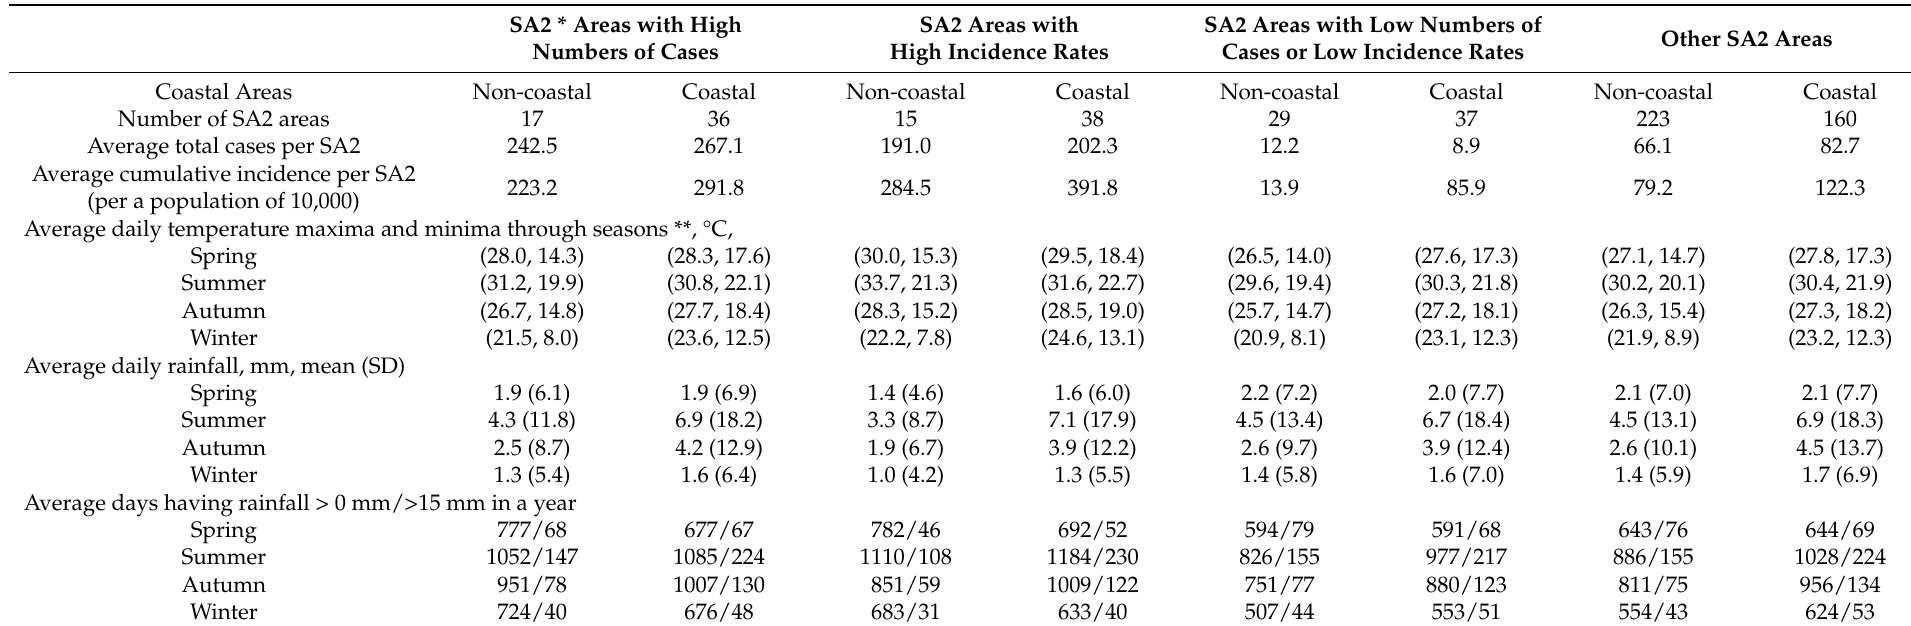
Table 1. The seasonal temperature and rainfall in SA2 areas with high numbers of cases or high incidence